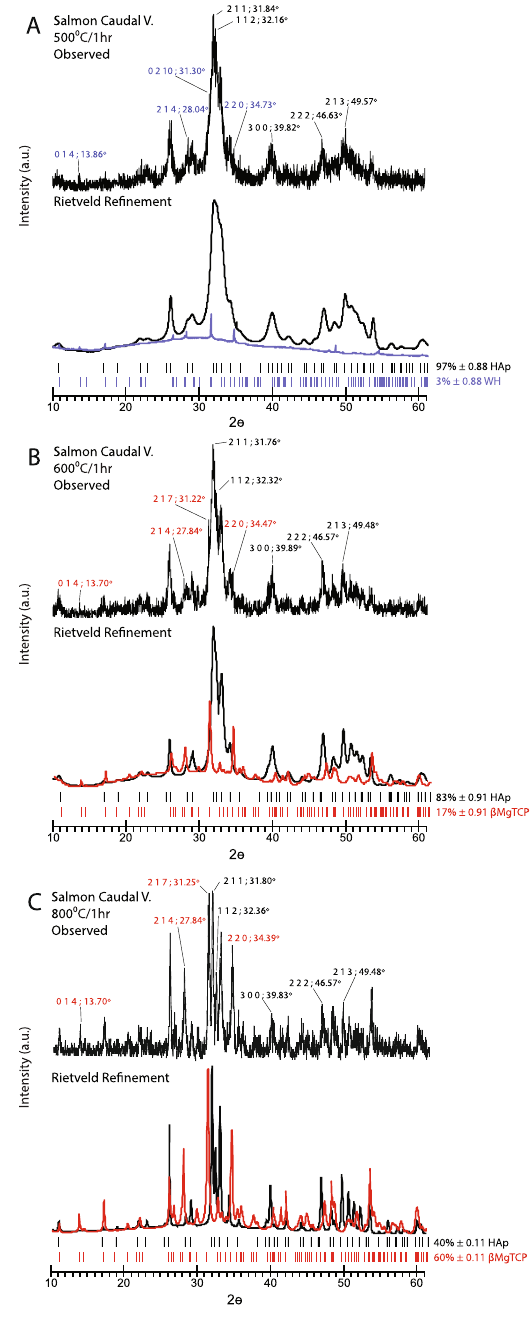
Figure 6. Observed XRD Diffractograms and Rietveld Refinements for Heat Treated Atlantic Salmon Bone. Each inset displays the observed diffractogram on top followed by refinement results on bottom; diagnostic reflectance planes and corresponding 2 θ angles for each phase are indicated in the observed diffractograms; separated phases are presented in the refinement sections; hydroxylapatite (HAp) is represented in black, whitlockite (WH) in blue, and beta magnesium tricalcium phosphate ( β MgTCP) in red; ( A ) salmon caudal vertebra heat treated at 500 °C demonstrating diagnostic reflectance peaks for WH and HAp; ( B ) salmon caudal vertebra heat treated at 600 °C demonstrating diagnostic reflectance peaks for β MgTCP and HAp; ( C ) well developed biphasic HAp- β MgTCP in a salmon caudal vertebra after treatment at 800